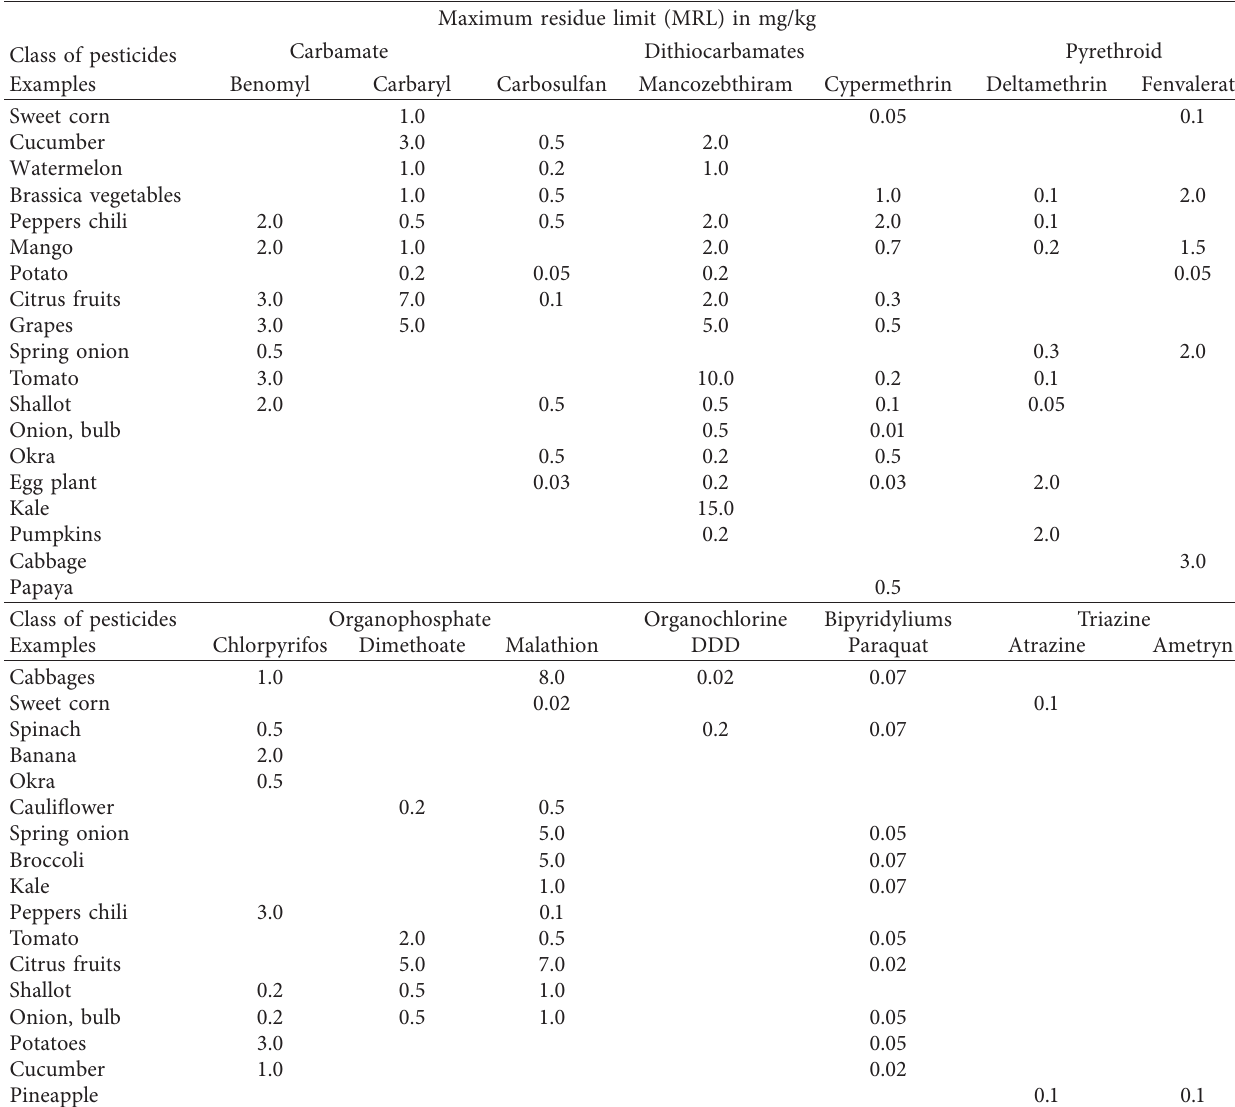
Table 1: Maximum residues’ limits of pesticides in fruits and